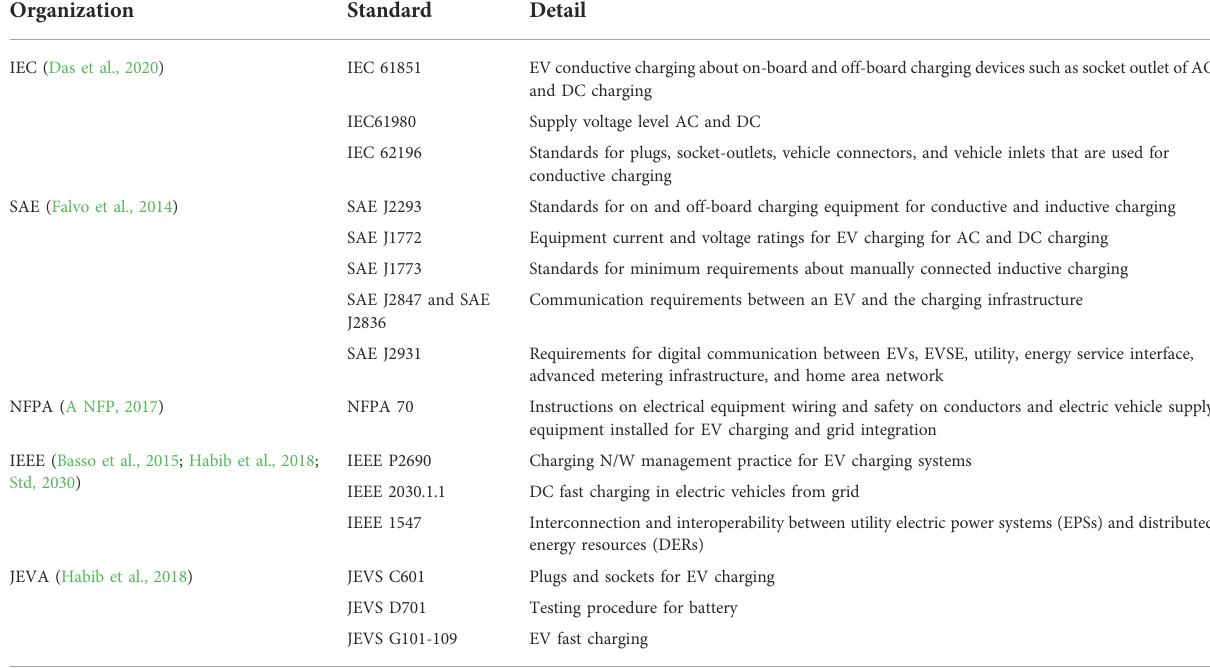
TABLE 7 Standards of electric vehicle charging and